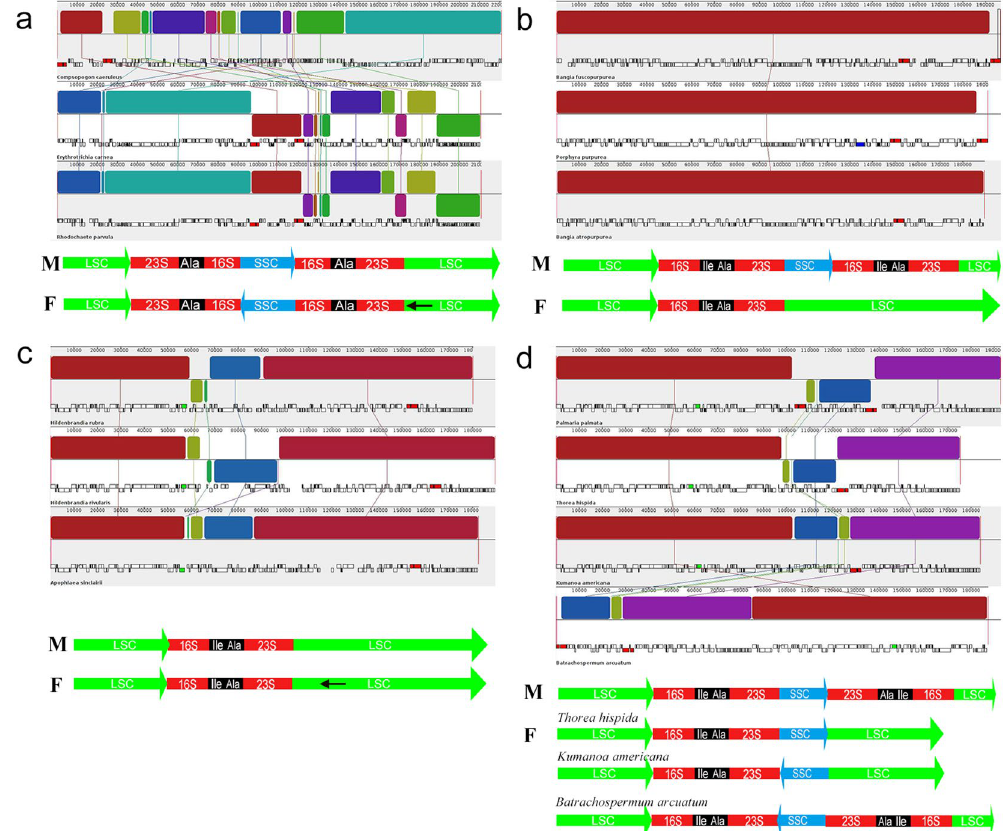
Figure 3. Synteny alignment of chloroplast genomes between freshwater and marine representatives. ( a ) Synteny alignment of chloroplast genomes between freshwater and marine Compsopogonophyceae. ( b ) Synteny alignment of chloroplast genomes between freshwater and marine Bangiophyceae. ( c ) Synteny alignment of chloroplast genomes between freshwater and marine Hildenbrandiophyceae. ( d ) Synteny alignment of chloroplast genomes between freshwater and marine Florideophyceae. Note: Lines with “M” and “F” mean types of chloroplast genome architecture for each Rhodophyta lineage. M represent marine species and F represent freshwater species; LSC and SSC represent genomic regions coding for large single copy and small single copy; 23 S and 16 S represent genes coding for 23 S rRNA and 16 S rRNA; Ala and Ile represent genes coding for tRNA-Ala and tRNA-Ile; Black arrows represent partial inverse of the LSC region. Lines connecting each colored bar with crossing “X” pattern represent genomic rearrangements or collinear structure annotated at different starting